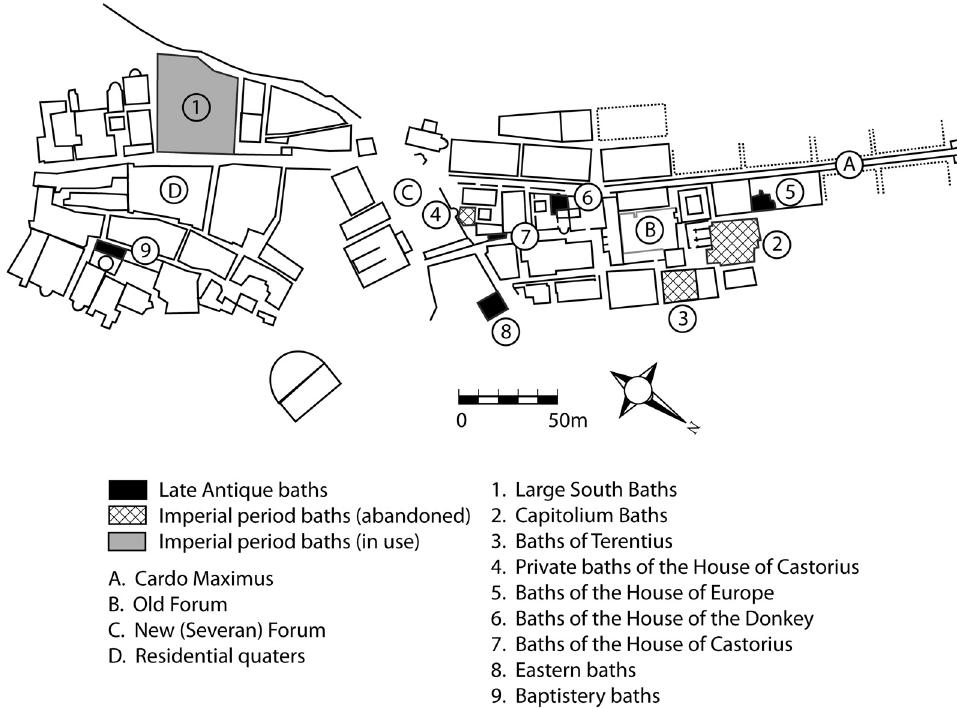
Figure 1: Schematized plan of Cuicul with the location of the baths (after Leschi 1953: general plan).